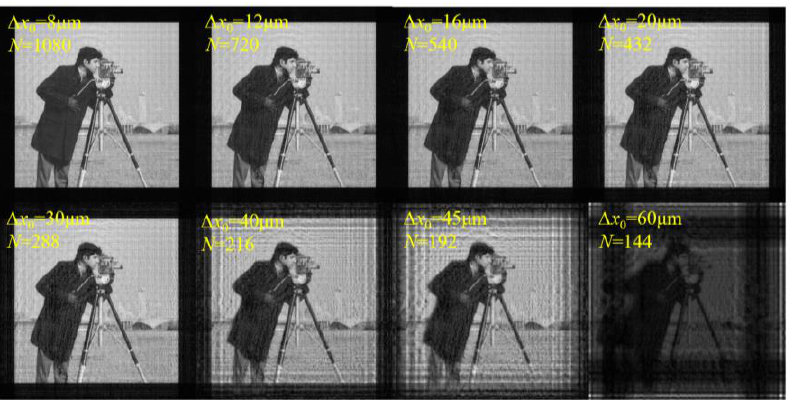
Figure 10. Calculated amplitude distributions on the diffraction plane with different ∆ x 0 and N us-